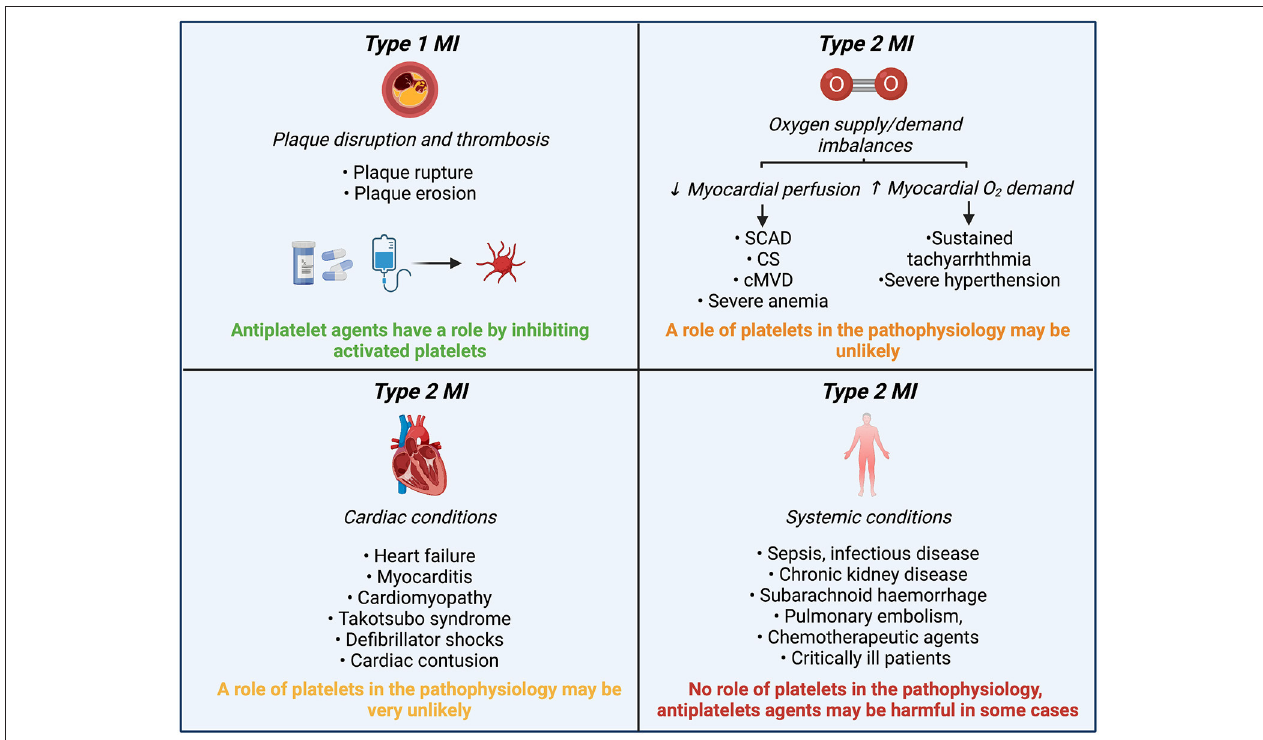
FIGURE 3 | Role of platelets and antiplatelet agents in MINOCA etiologies classified according to the 4th UDMI. MINOCA, myocardial infarction with non-obstructive coronary arteries; UDMI, universal myocardial infarction definition; MI, myocardial infarction; SCAD, spontaneous coronary artery dissection; CS, epicardial coronary spasm; cMVD, coronary microvascular